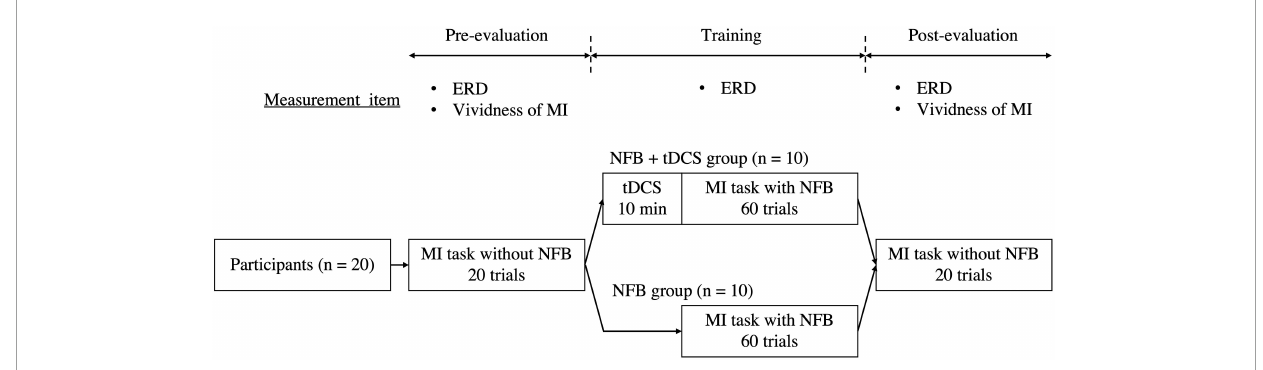
FIGURE1 Study protocol. Participants were divided into an NFB group ( n = 10) performing the MI task with NFB alone and a tDCS + NFB group ( n = 10) performing the MI task with NFB after 10 min of tDCS. ERD and MI vividness were evaluated before and after the training phase. In the training phase, ERD during the MI task was also evaluated. MI, motor imagery; NFB, neurofeedback; tDCS, transcranial direct current stimulation; ERD, event-related desynchronization.